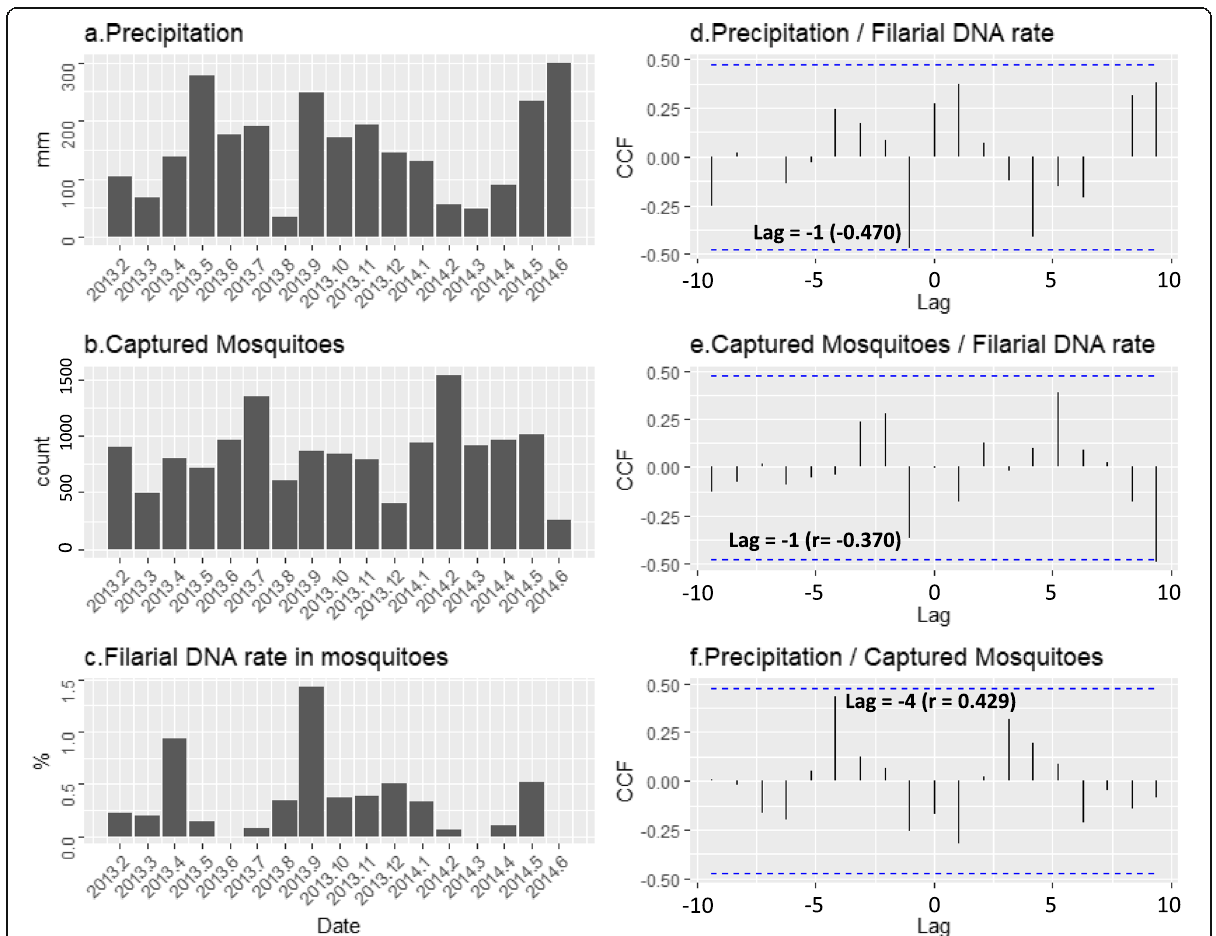
Fig. 3 Seasonal fluctuation of precipitation, number of captured mosquitoes, filarial DNA rate in mosquitoes and results of their statistical analysis. The left column of figure illustrates Data of precipitation ( a ), number of captured mosquitoes ( b ), and filarial DNA rate in mosquitoes ( c ) between February 2013 and June 2014. The right column shows partial autocorrelation of precipitation data using R autoplot function ( d ), cross-correlation coefficient (CCF) between precipitation and filarial DNA rate ( e ), and between captured mosquitoes and filarial DNA rate ( f ) using R autoplot